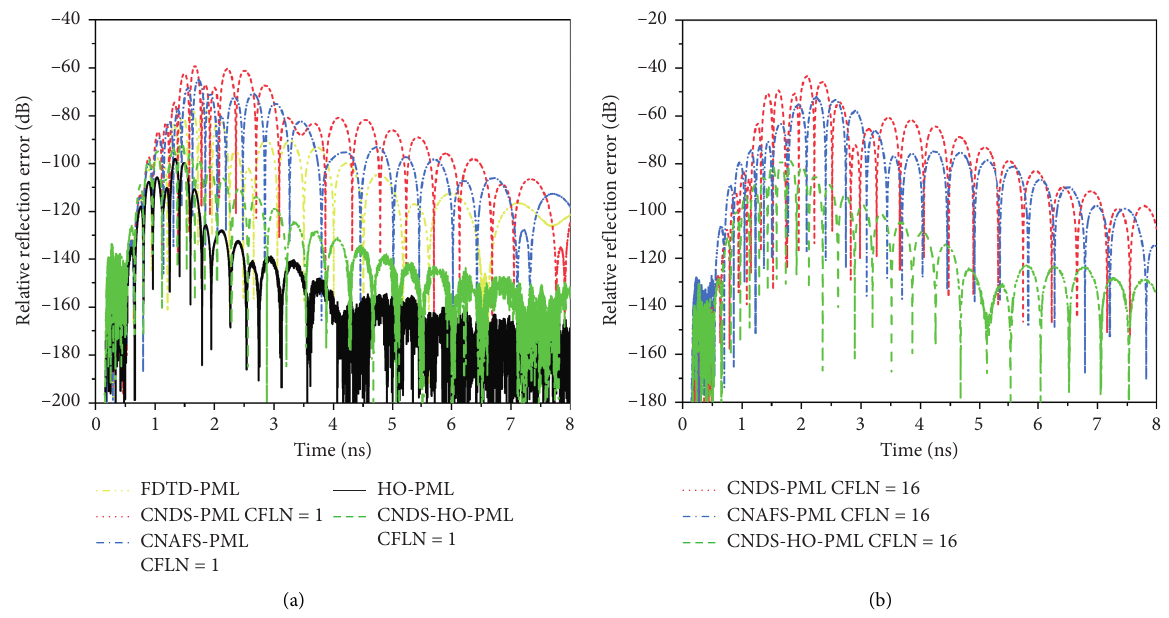
Figure 7: The relative reflection error versus time obtained by (a) FDTD-PML, CNDS-PML, CNAFS-PML, HO-PML, and CNDS-HO-PML when CFLN � 1; (b) CNDS-PML, CNAFS-PML, and CNDS-HO-PML when CFLN �